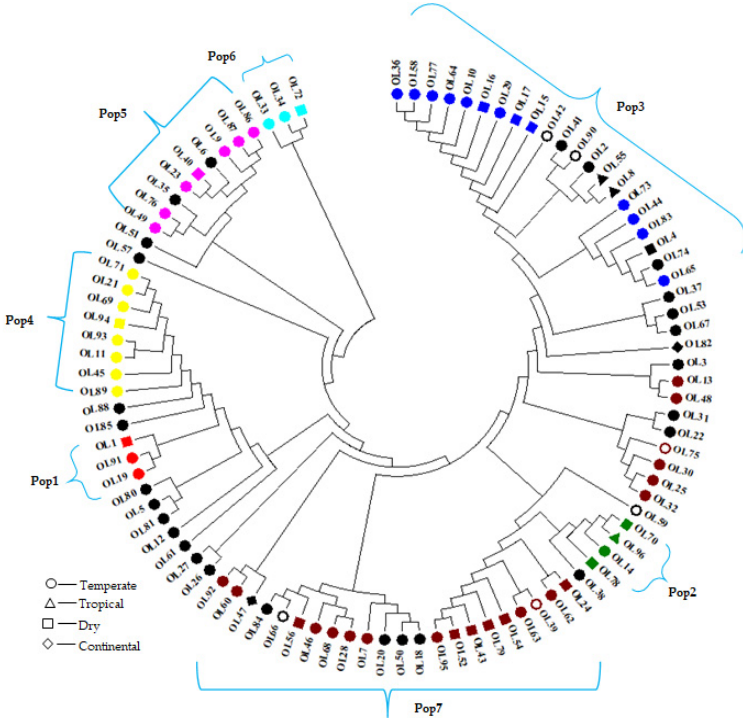
Figure 5. Phylogenetic analyses of the 96 olive cultivars using the neighbor-joining method. Different colors depict the structure analysis generated populations. Legends indicate the climatic zones from where the accessions were originated. Colors represent different subpopulations of the germplasm; red color = subpopulation1, green = subpopulation2, blue = subpopulation3, yellow = subpopulation4, pink = subpopulation5, cyan = subpopulation6, maroon = subpopulation7, black = admixture group.